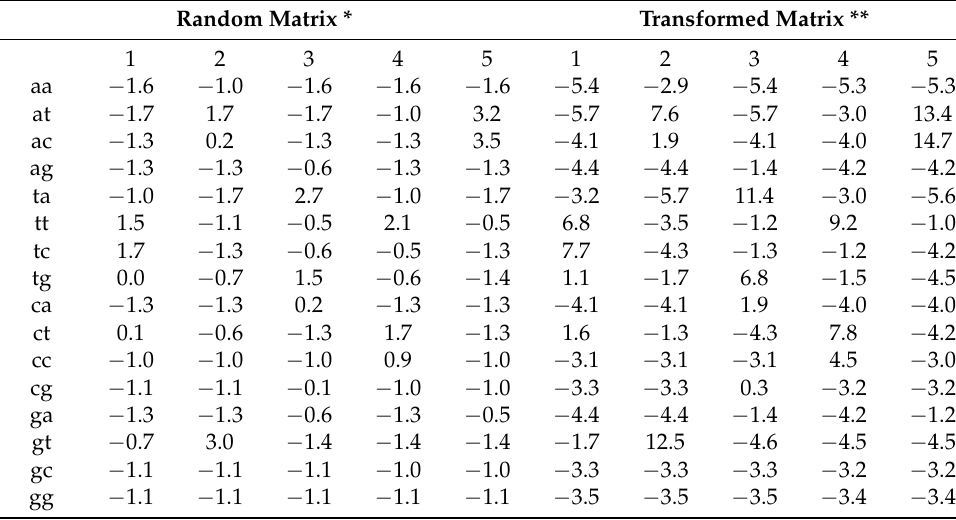
Table 1. An example of matrix transformation to the given R 2 and K d . Random Matrix